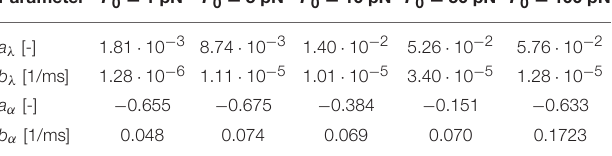
TABLE 2 | Homogenized axon parameters a λ and b λ to calculate the half damage stretch λ 50 according to Equation (19) and a α and b α to calculate the damage slope α according to Equation (20) for a range of characteristic bond strengths F 0